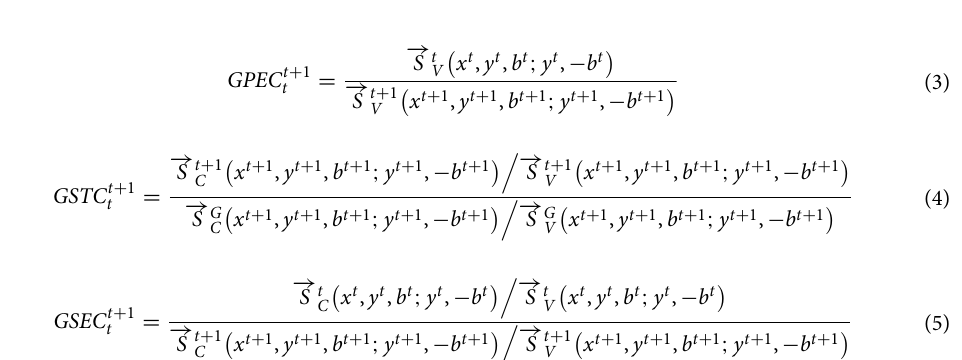
Table 1. Division of sub-urban agglomeration and corresponding cities. Coastal urban agglomeration indicates coastal urban agglomeration in the Western Taiwan Strait Region. Due to missing data, Hong Kong and Macau are not included in the scope of this